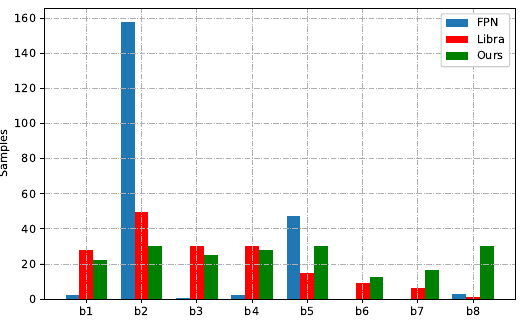
Figure 8. Distribution of multi-scale balanced,FPN and Libra RCNN sampling method.